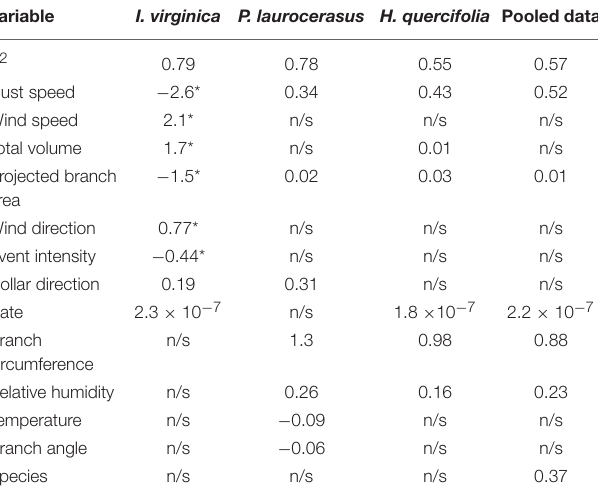
TABLE 2 | Regression